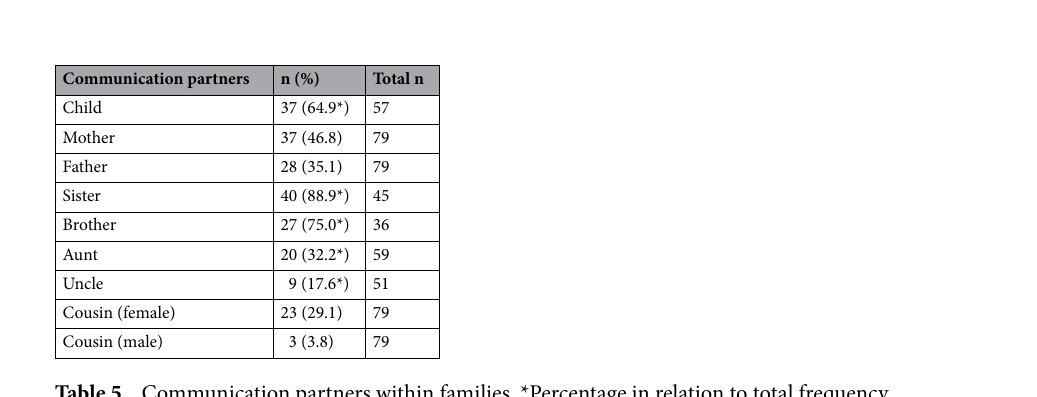
Table 5. Communication partners within families. *Percentage in relation to total